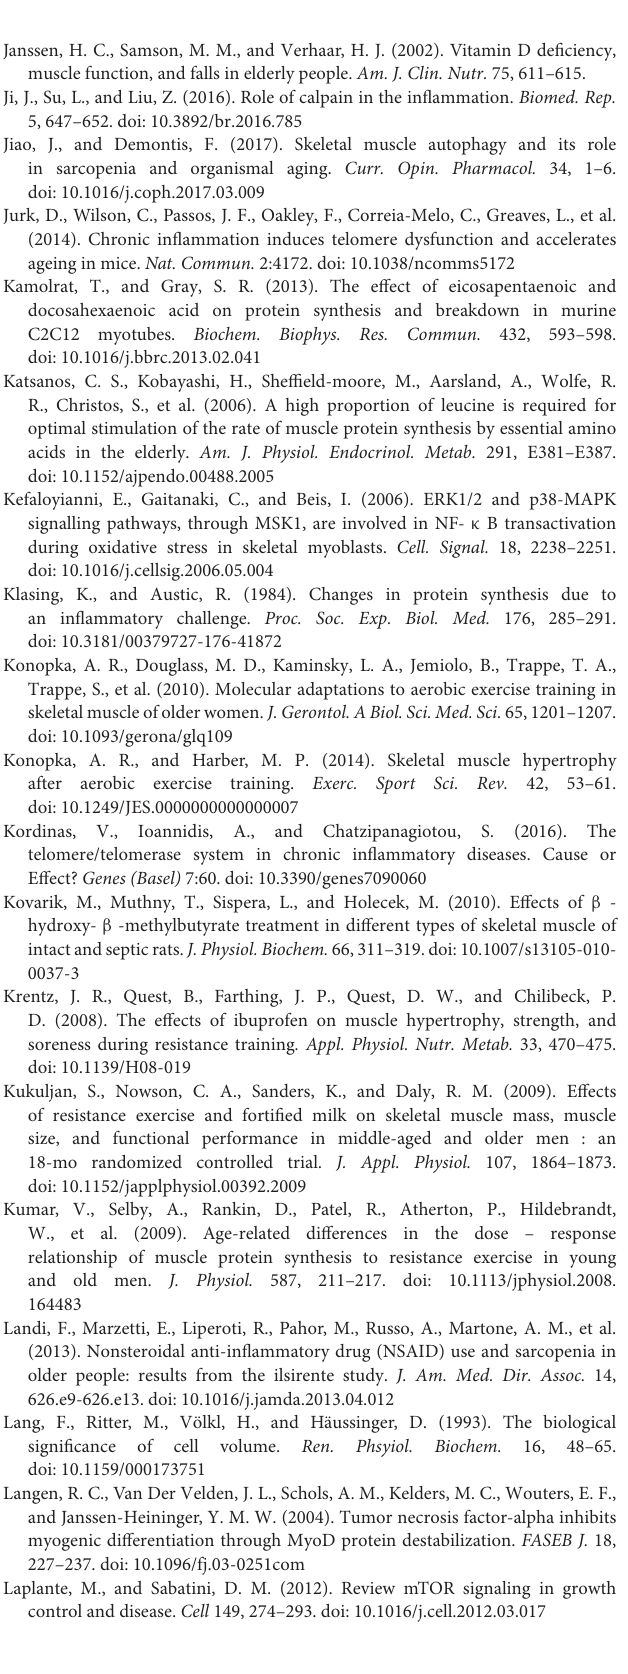
Frontiers in Physiology |